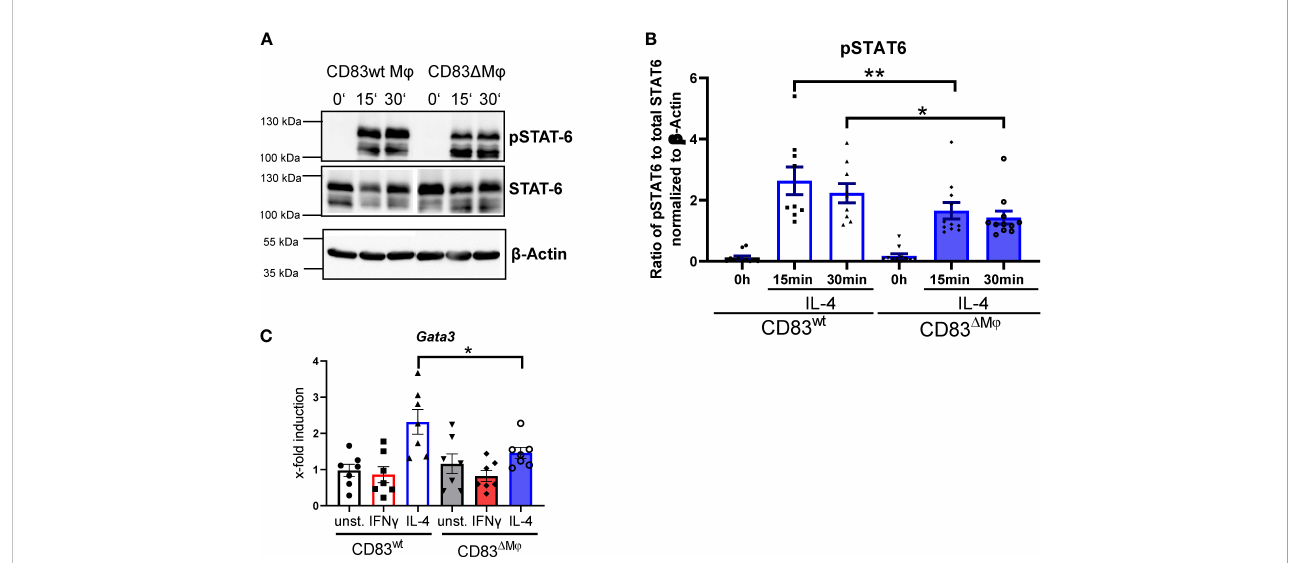
FIGURE 4 STAT6 phosphorylation is altered in CD83-de fi cient macrophages upon IL-4 stimulation. Bone-marrow derived M j were generated from CD83wt or CD83 cKO mice and stimulated with IL-4 for 15 or 30 min. Unstimulated M j served as control. Subsequently, whole cell lysates were prepared and analyzed by Western blot. (A) Representative Western blot showing pSTAT-6, STAT6 and b Actin levels in whole cell lysates derived from CD83wt and CD83 D M j animals (B) Quanti fi cation of the ratio of pSTAT-6 and STAT6 normalized to b -actin (n ≥ 9). (C) qPCR analyses of Gata3 mRNA levels in M j generated from cKO or wt mice, stimulated with IFNg or IL-4. Signi fi cantly reduced Gata3 mRNA levels are observed in IL-4 stimulated CD83-de fi cient M j . Statistical analyses were performed by One-way ANOVA or the appropriate corresponding non-parametric test. Data are represented as mean ± SEM. Experiments were performed at least three times. *p< 0.05; **p<0.01. The absence of asterisks indicates that there is no statistical signi fi